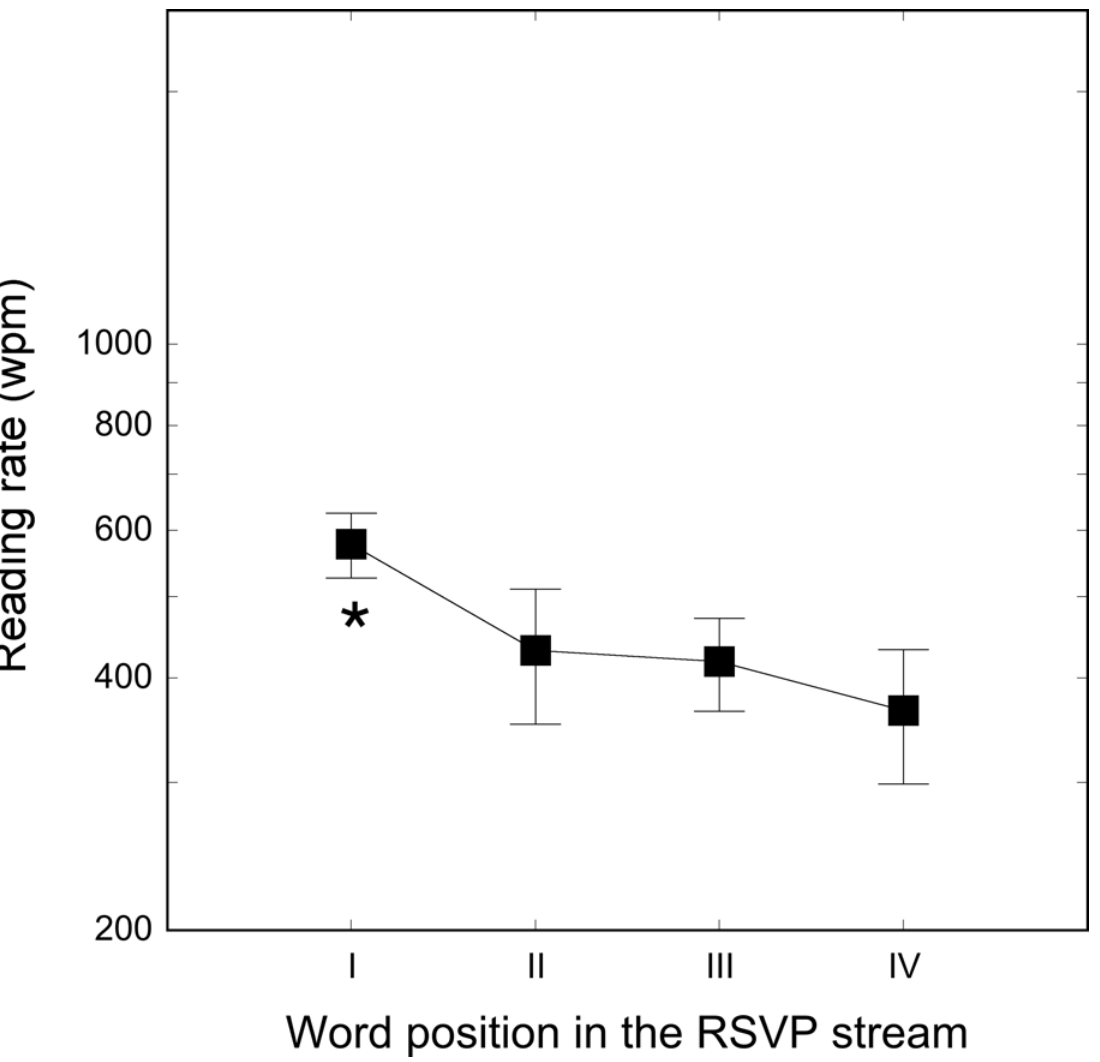
Fig 3. Reading rates separately for each of the four word ordinal positions in the stream. As in experiment 2 each threshold was independently measured using a 120 words list. The first word was immediately preceded, and the last word was immediately followed, by a mask. Bars represent standard deviations. * indicates p-value <